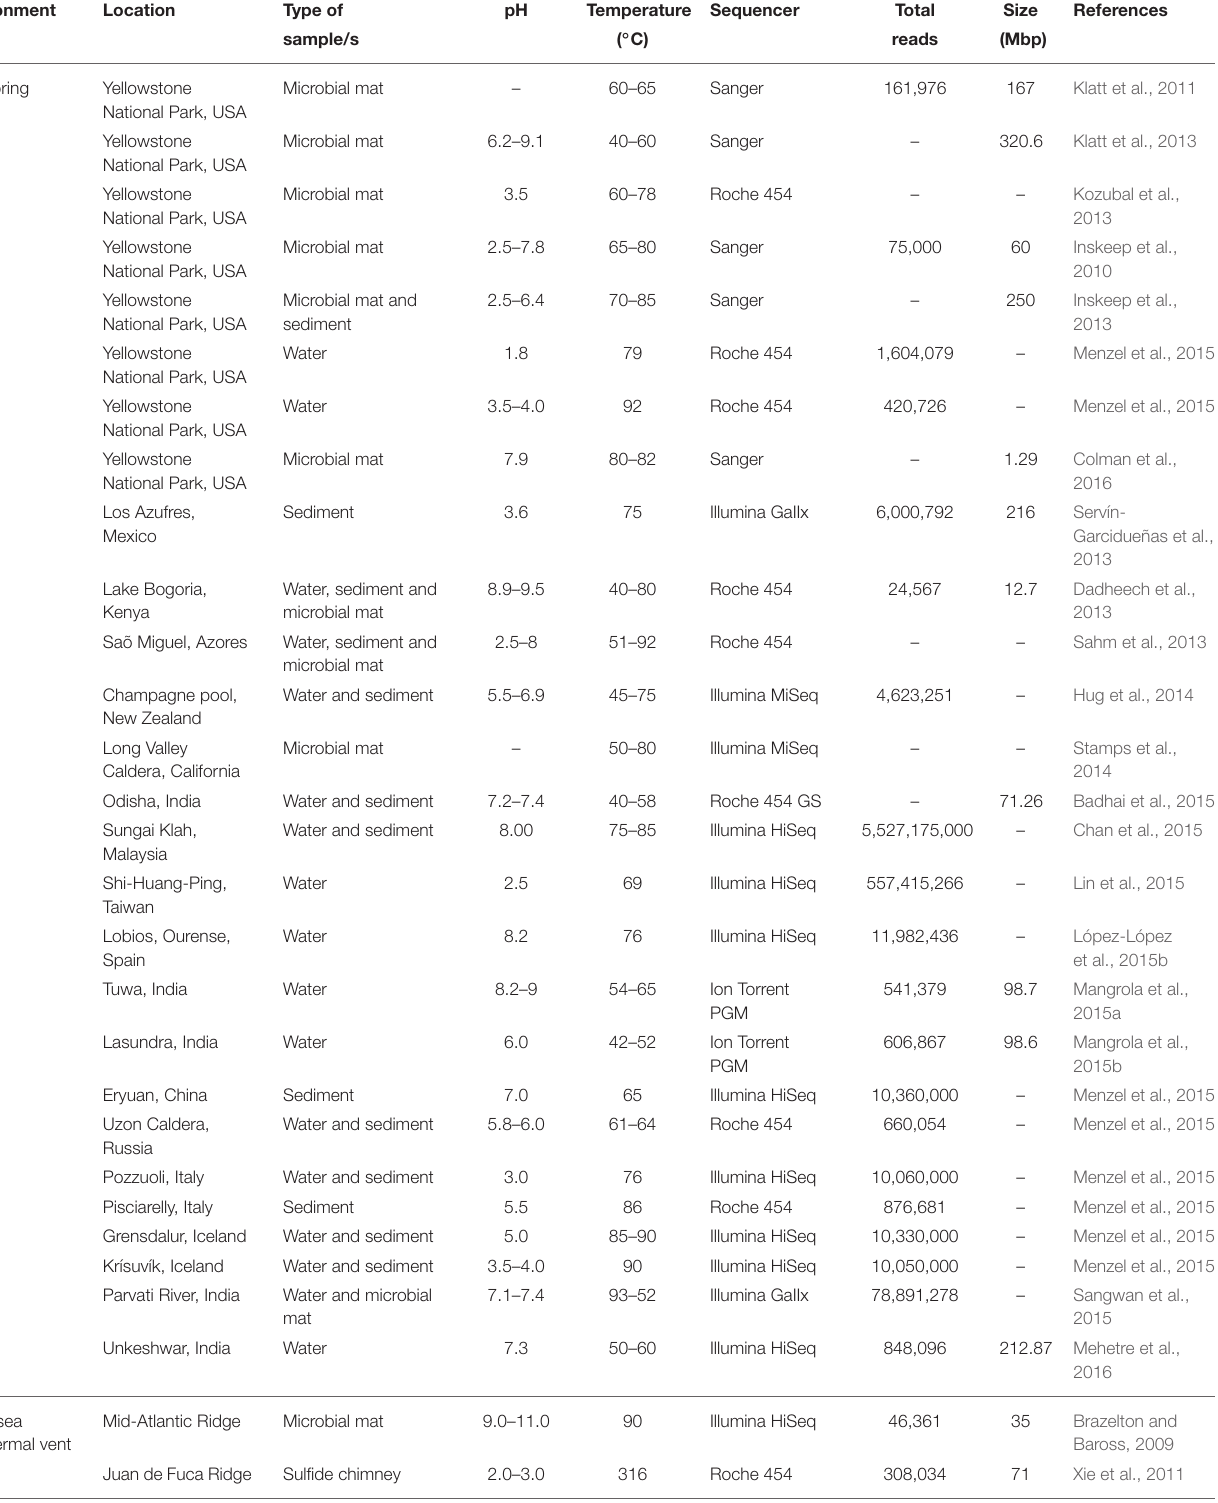
TABLE 2 | Examples of high temperature environments studied with shotgun metagenomics.